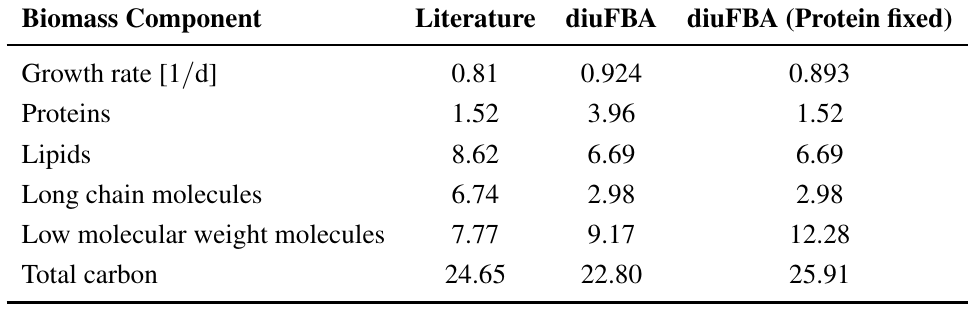
Table 2. Biomass carbon distribution in pg C / cell after a light phase of 16 h, calculated from Fernandez et al. [34], compared to the optimal biomass composition at the same time calculated via diuFBA. For the third column, the protein production was fixed to the literature value.